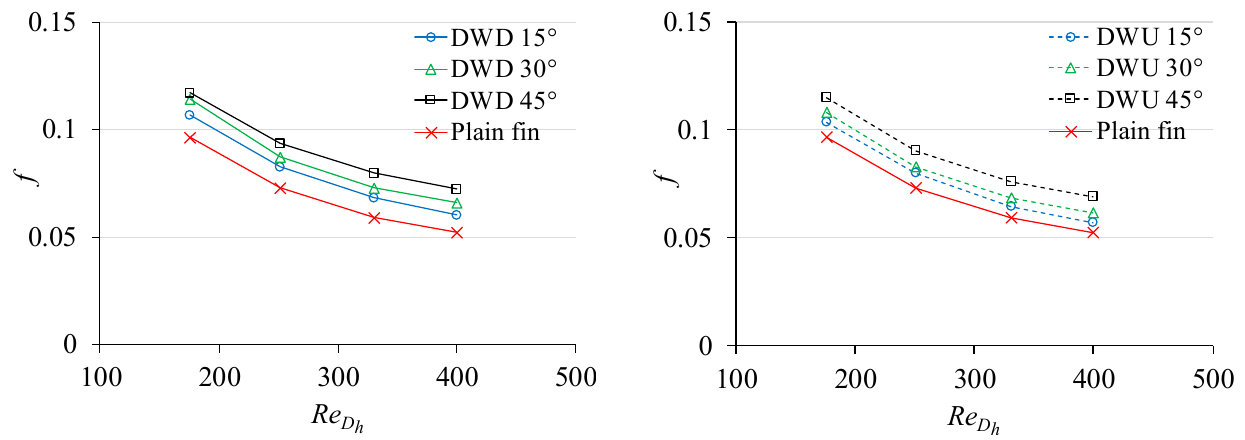
Figure 12. The effect of attack angle on friction factor for air-to-water FTHEX with delta-winglet downstream (DWD, solid lines) and delta-winglet upstream (DWU, dashed lines) configurations. Test conditions: T air,in = 22 °C, T water,in = 40 °C, w water,in = 0.76 m/s.